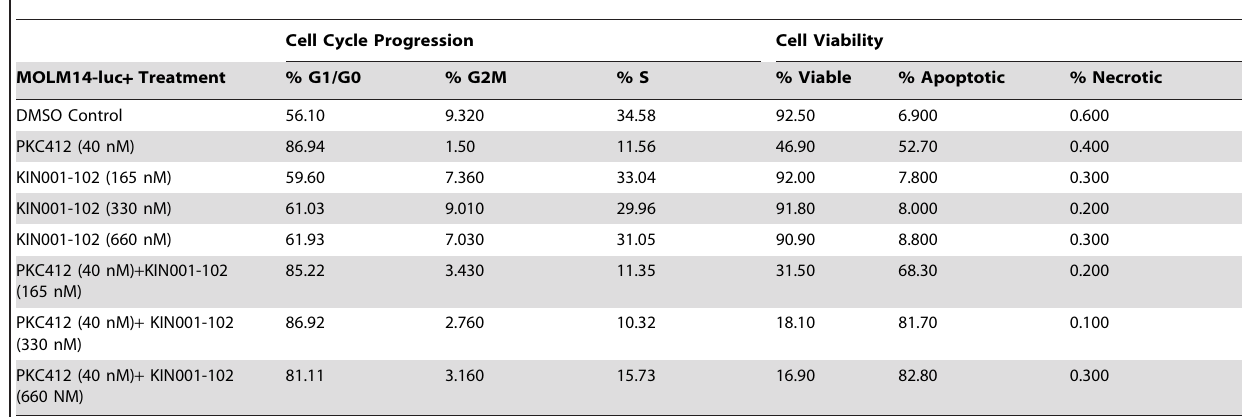
Table 2. Effects of PKC412 and KIN001-102, alone and combined, on MOLM14-luc + cell cycle progression (following 24 hours of treatment) and apoptosis (following 48 hours of treatment) when cells are cultured in the presence of RPMI + 10% FBS.